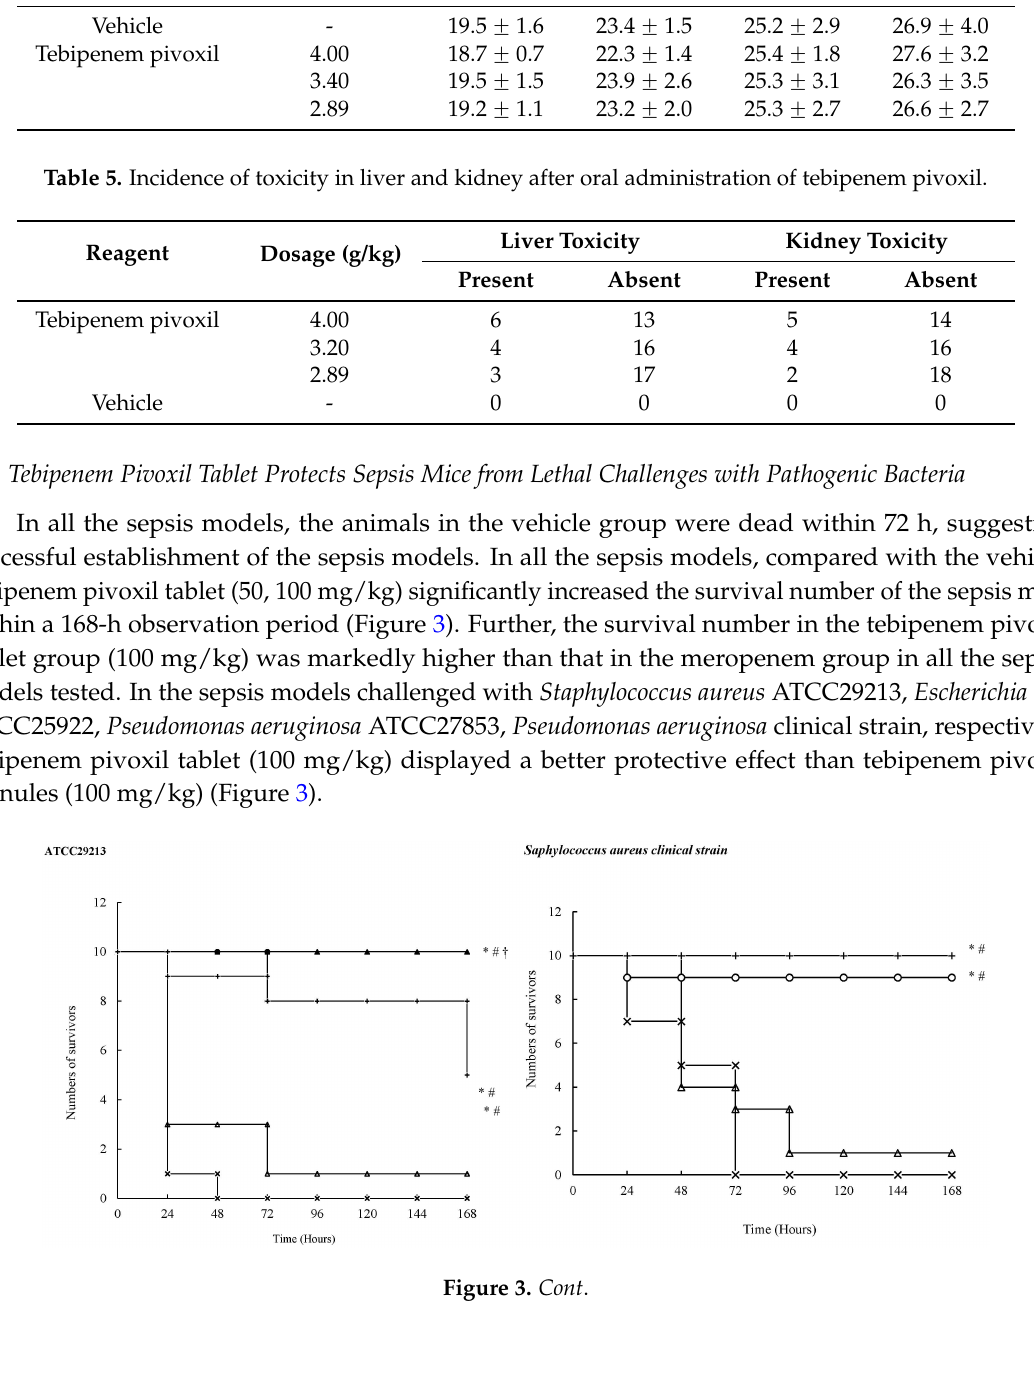
Body Weight (g) Time after Administration (Day) 0